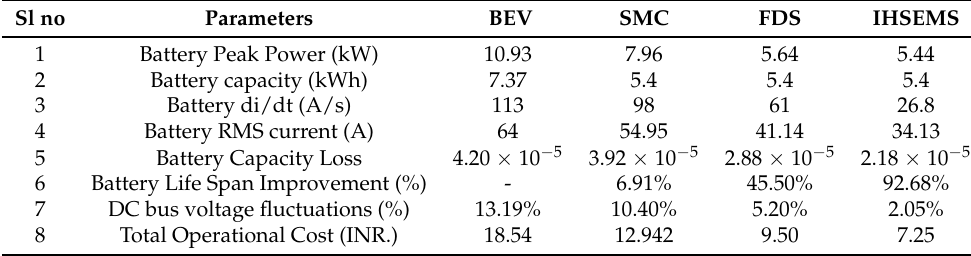
Figure 18. Comparison of DC BVF bus voltage fluctuations with SMC, FDS, and IHSEMS under NYCC driving cycle. Table 4. Performance and economy analysis of